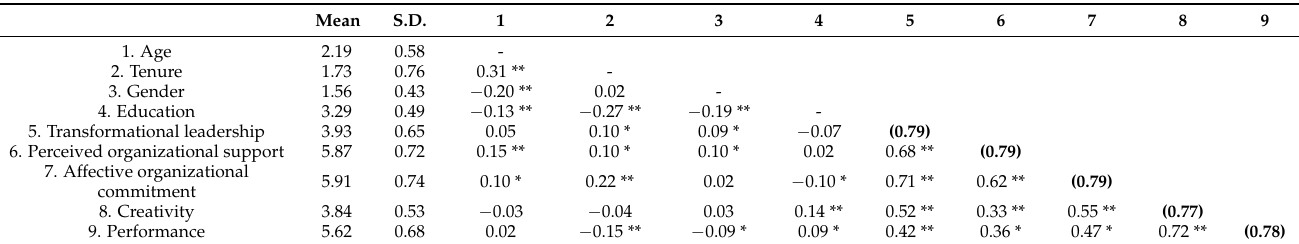
Table 3. Means, standard deviations, and correlations for the variables.